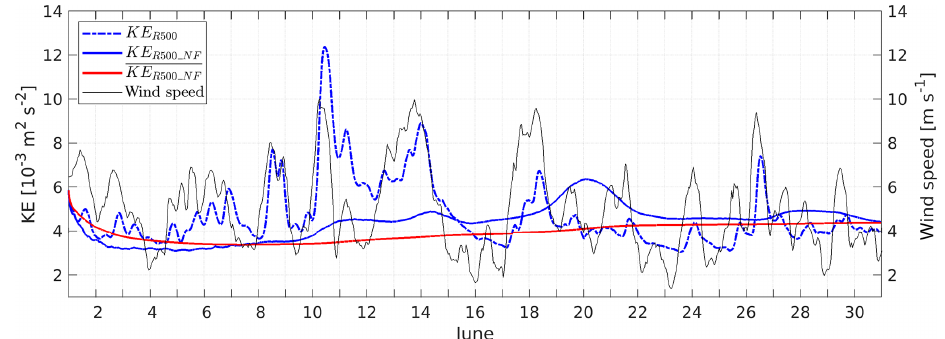
Figure 3. Instantaneous (KE R500 , KE R500_NF ) and cumulatively averaged (KE R500_NF ) kinetic energy per unit mass of the model runs R500 and R500_NF. The wind speed is shown as a black curve. All quantities are averaged over the model